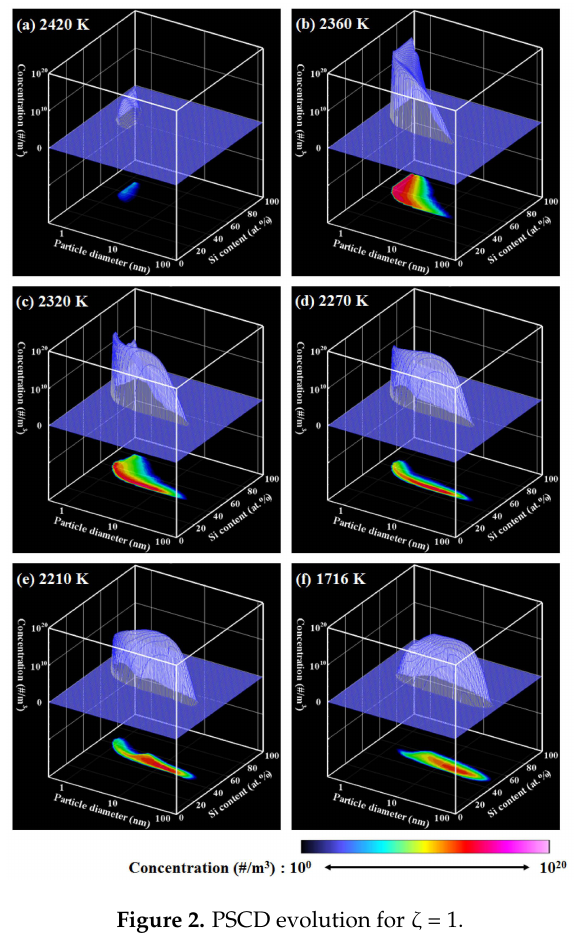
Figure 2. PSCD evolution for ζ = 1.